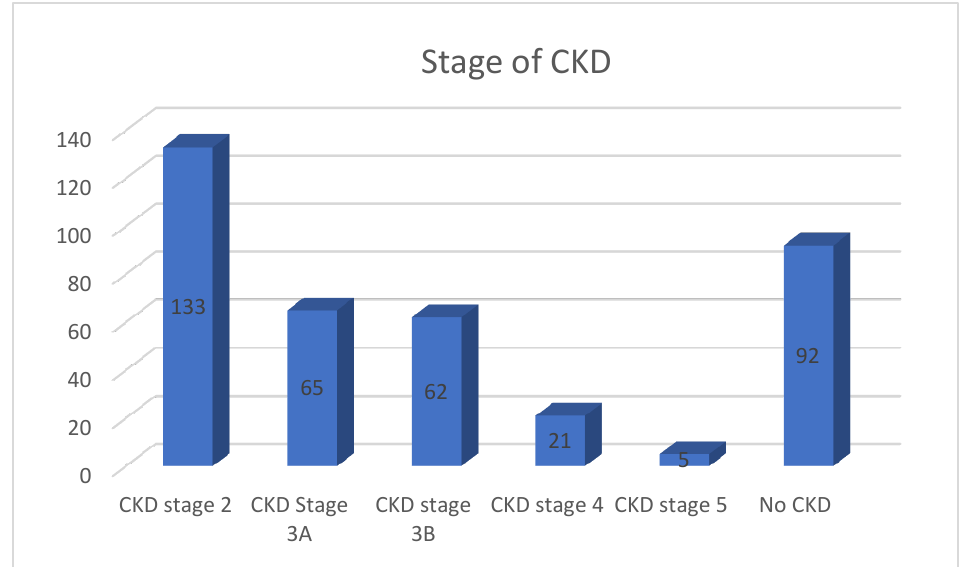
Figure 2. CKD grade following COVID-19 infection.